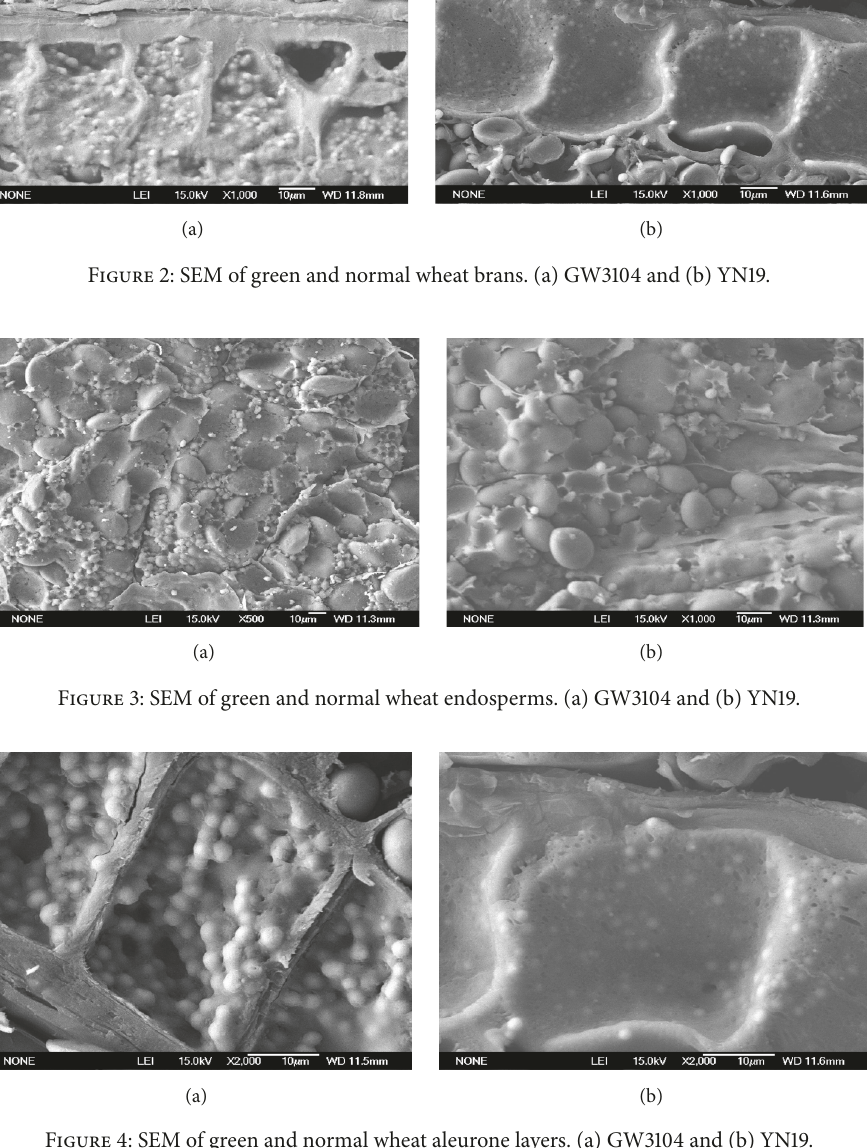
Figure 4: SEM of green and normal wheat aleurone layers. (a) GW3104 and (b)